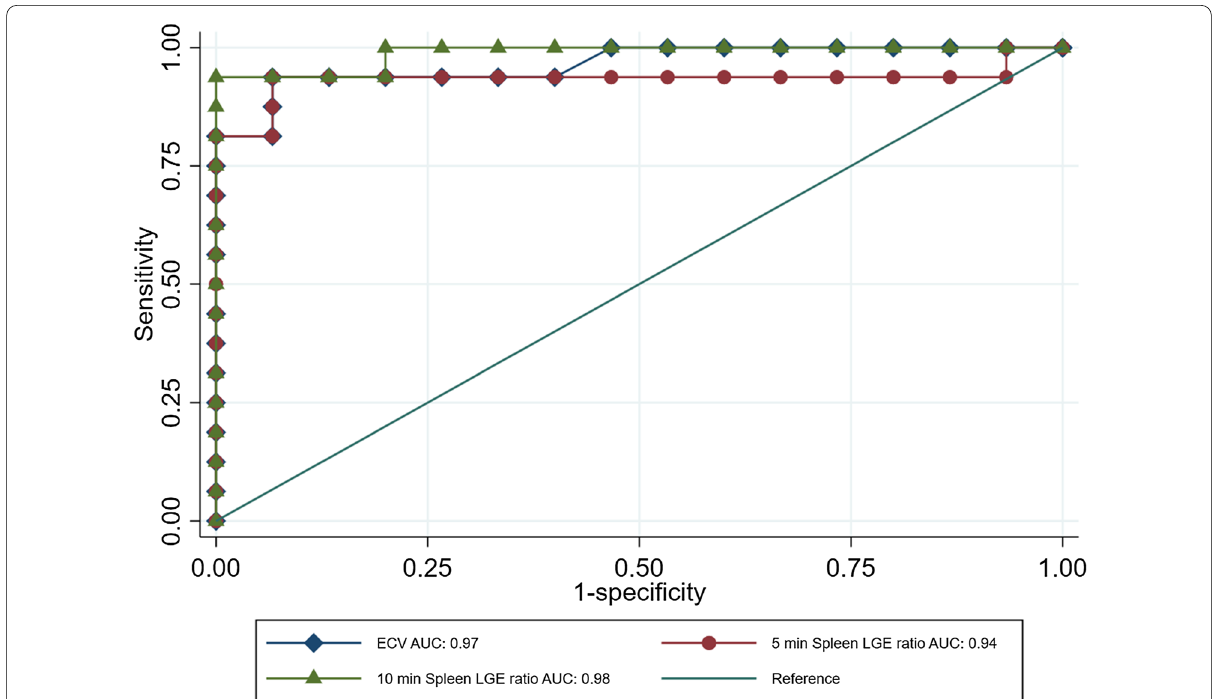
Fig. 3 Spleen normalized LGE ratio at 5 and 10 min, and spleen ECV between those AL patients with and without spleen